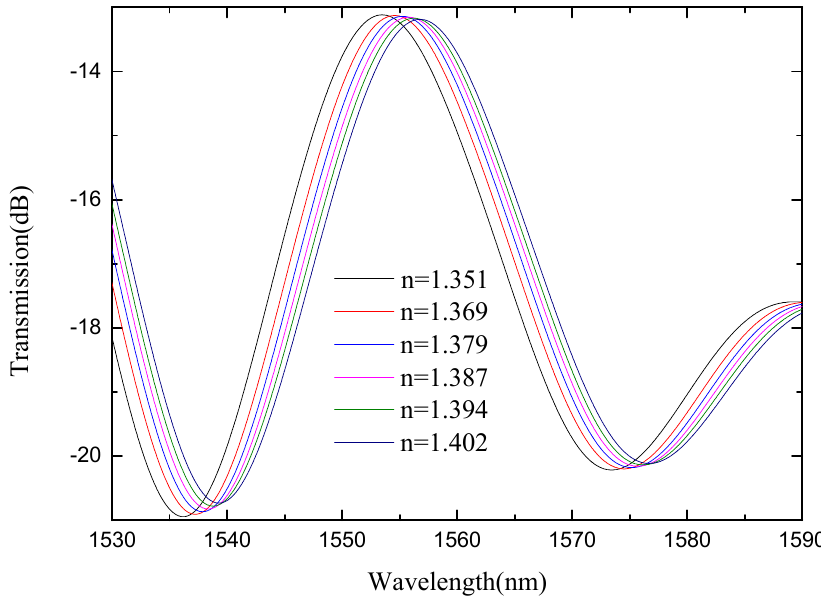
Figure 15. Spectra of SMBMS MZI(1/3L) with the position of the bitaper set to one third of the sensing arm at different refractive indices.